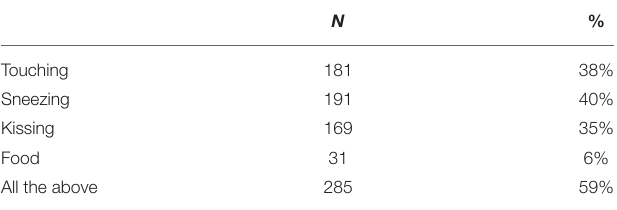
TABLE 3 | COVID-19 infection knowledge.